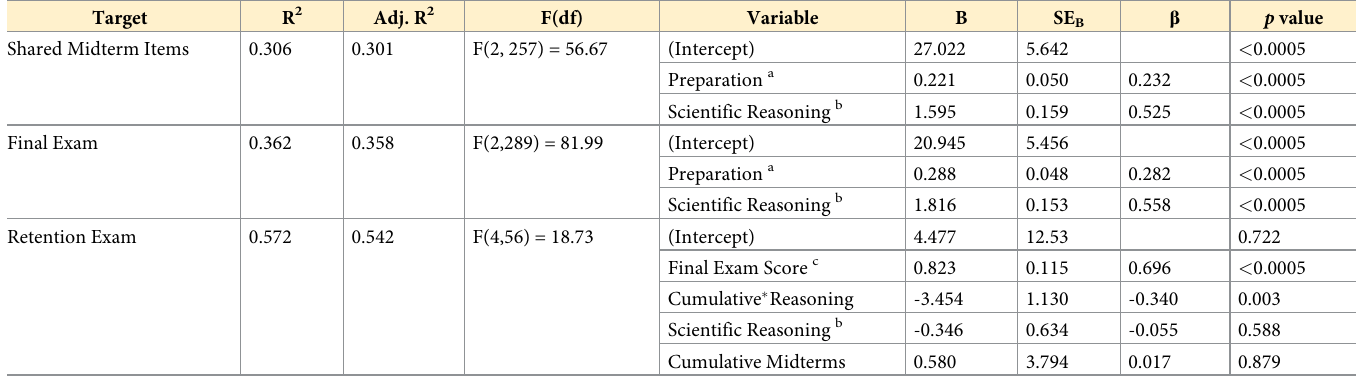
Table 2. Final results multiple linear regression to target student performance (% correct) on